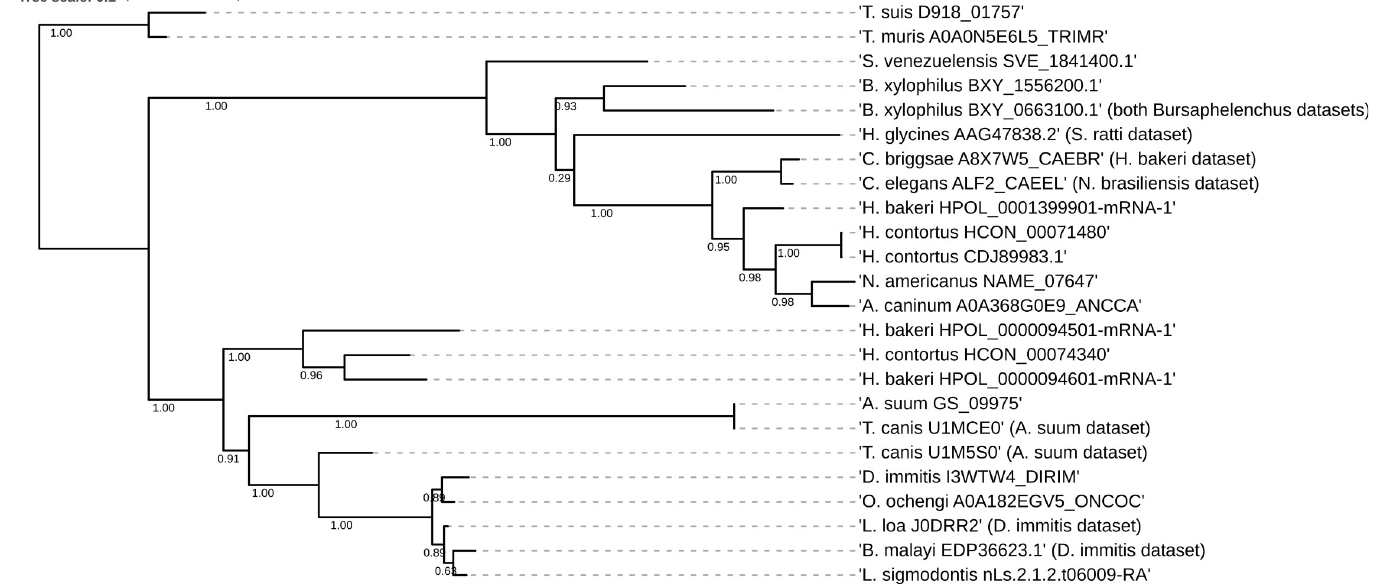
Fig 3. Maximum likelihood phylogeny of aldolase protein sequences. Scale bar represents distance. Numbers indicate the SH-like support for each node. The tree is rooted at the divergence of clade I nematodes. The tree follows the expected divergence based on species. The presence of multiple sequences from a species at different points in the tree indicates the presence of gene duplication. The aldolase orthogroup is likely represented by two genes, which form two groups; within each group, the expected phylogeny is respected. B . malayi and S . lupi also showed aldolase sequences, which are not depicted in this graph due to sequence selection described in the methods